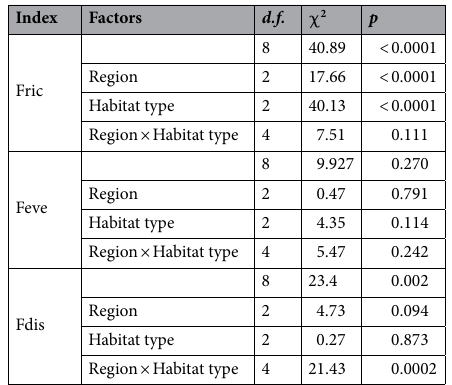
Table 2. GLMM analysis considering the region, the habitat types, and their interaction on dung beetles functional richness (Fric), functional evenness (Feve), and functional dispersion (Fdis) in subtropical forests of Argentina. d.f. : degrees of